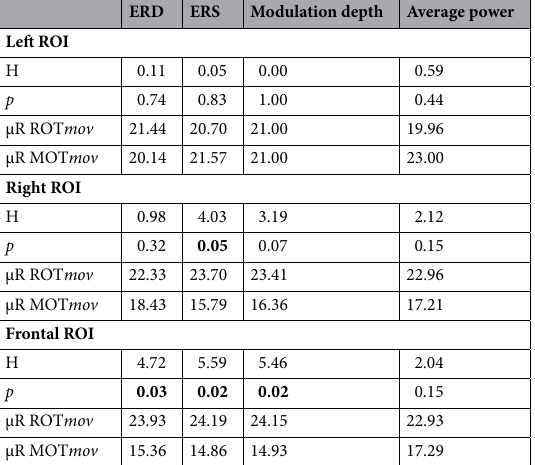
Table 3. Comparison of between-blocks ( mov 3– mov 0) ROT mov and MOT mov differences in beta ERD, ERS, modulation depth and mean power magnitude with independent-samples Kruskal–Wallis test for each ROI. Significant differences are reported in bold (p < 0.05). Degrees of freedom = 1 in all cases. H, test statistic; p, p values; μR, rank